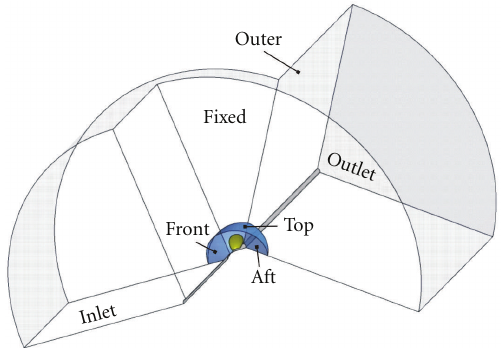
Figure 8: E779A, computational domain.